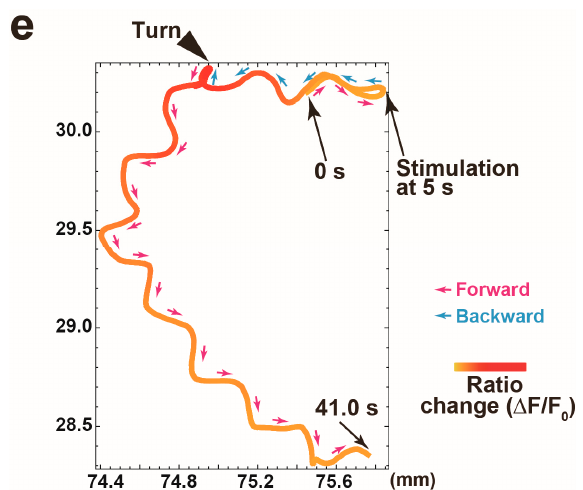
Figure 3. Proof of principle experiment for quantification of calcium signal in the AVA neuron while a worm responds to 1 kHz of nonlocalized vibration. ( a ) The representative filmstrip showing a GCaMP signal of the AVA neuron in a worm responding to nonlocalized vibration. Frames displayed here are separated by 2 s, but actual time resolution is higher. ( b – d ) The representative time traces of the intensities of GCaMP ( b ) and TagRFP ( c ) fluorescences and the ratio change ( d ) in a worm responding to nonlocalized vibration. ( e ) A trajectory of a worm with a calcium signal intensity of the AVA neuron indicated in ( d ). The arrowhead indicates the end of backward movement. The position where nonlocalized vibration was evoked is indicated as ‘Stimulation’.